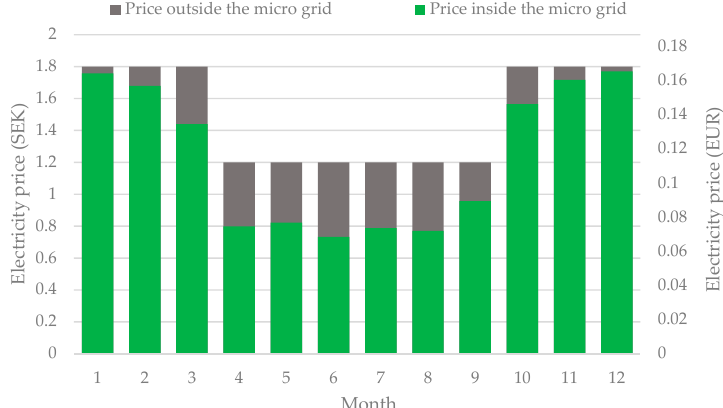
Figure 10. Monthly difference in price between the energy offered by the parent grid and the average paid by the shareholders in a LEC gratis arrangement.